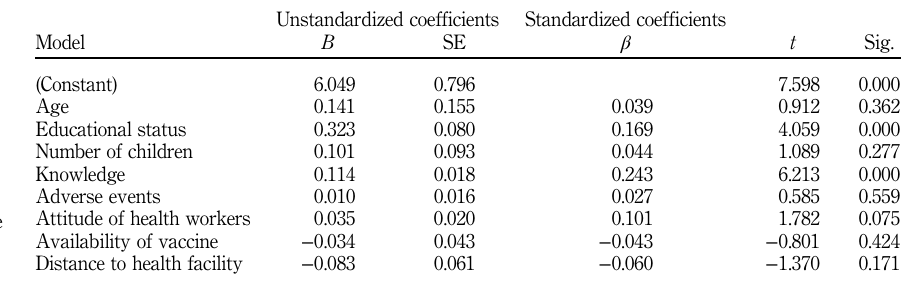
Mothers ’ compliance with routine